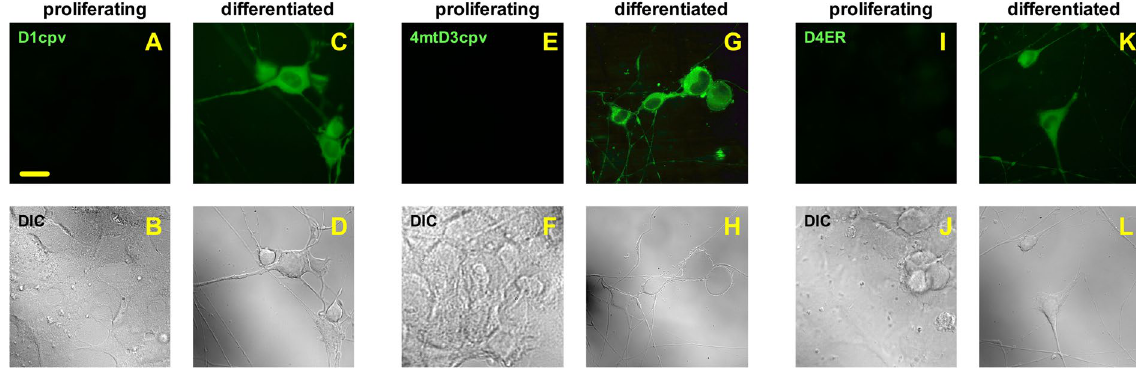
Figure 1. The cameleon probes under the control of the Hb9-derived promoter are expressed in differentiated, but not in proliferating, NSC-34 MN cells. NSC-34 cells were infected with the AAV vectors coding for the Hb9_AB-driven, MN-specific, cameleon probes targeted to the cytosol (D1cpv, panels A–D), the mitochondrial matrix (4mtD3cpv, panels E–H), or the ER lumen (D4ER, panels I–L), and cultured under non-differentiating (proliferating, panels A,B,E,F,I,J) or differentiating (by growth in the presence of retinoic acid 5 μ M, 192 h, panels C,D,G,H,K,L) conditions. Fluorescence ( λ ex = 488 nm, λ em = 526/550 nm) and differential interference contrast (DIC) micrographs of representative fields were taken with a suited microscope equipped with a